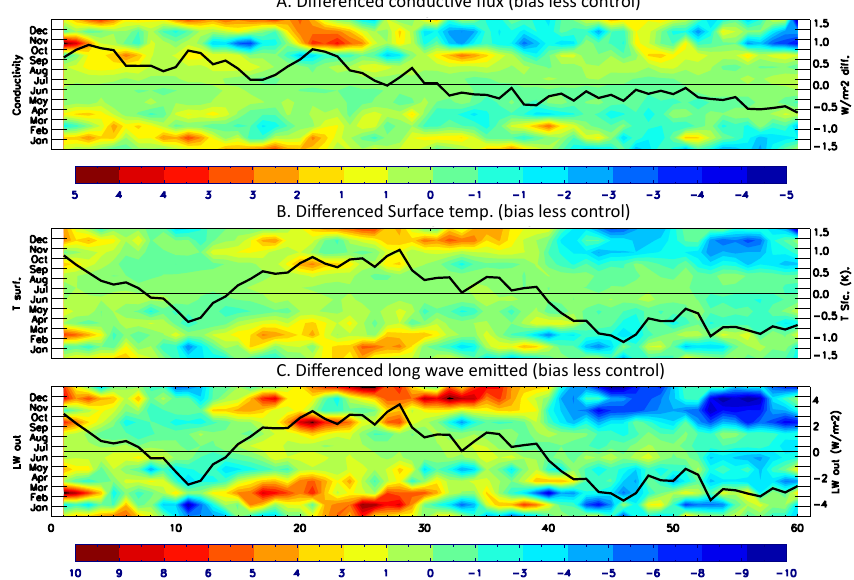
A. Differenced conduc.ve flux (bias less control)